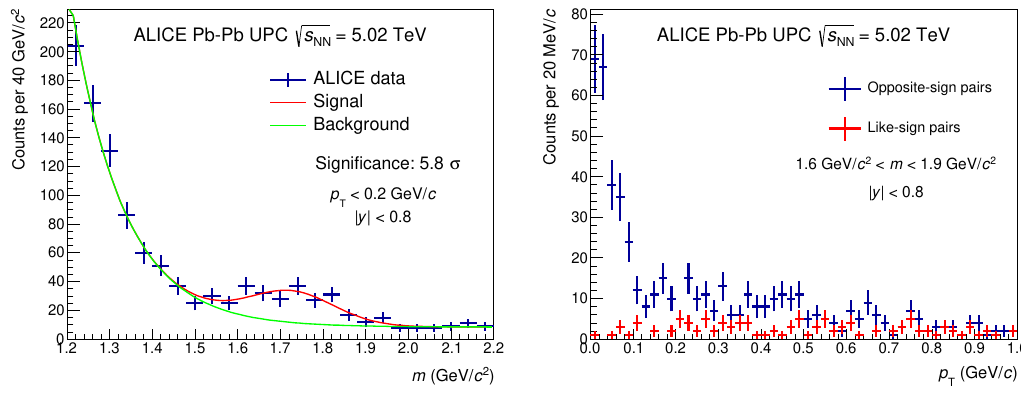
Figure 4 . (Colour online). Invariant mass (left) and transverse momentum (right) distributions of pion pairs at large invariant masses. The lines correspond to the (cid:12)t components described in the text. The symbols depict the signal and like-sign background